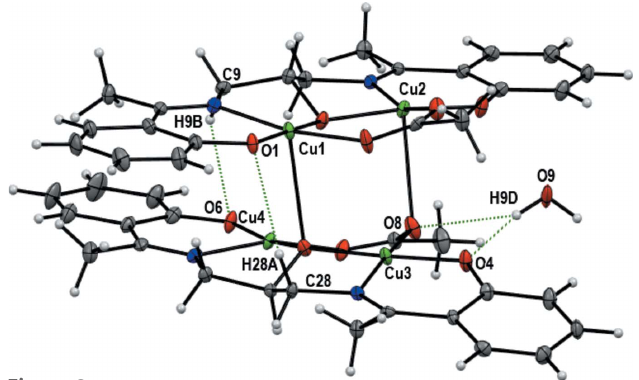
Figure 2 Detail of the structure of the complex showing the O—H (cid:2)(cid:2)(cid:2) O and C— H (cid:2)(cid:2)(cid:2) O hydrogen bonds.